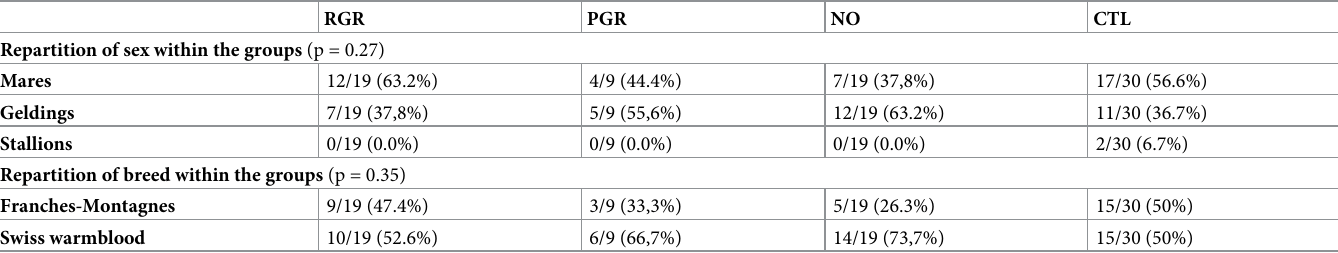
p-values refer to variations of sex and breed distribution among groups. Abbreviations: RGR = regression, PGR = progression, NO = new occurrence, CTL = control.